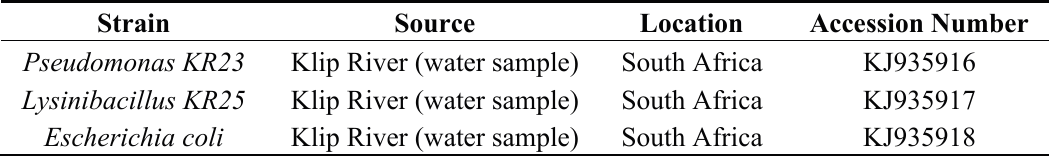
Table 5. Bacterial strains used for heavy metal gene